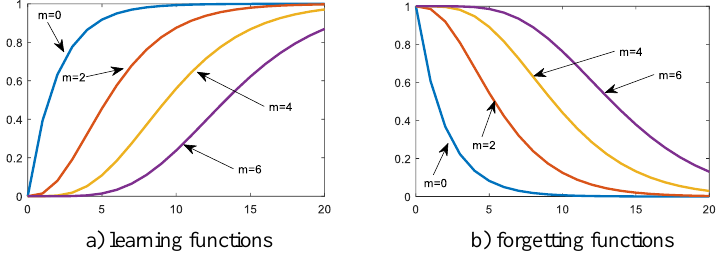
Fig. 6. Parameterization of the functions of learning and forgetting